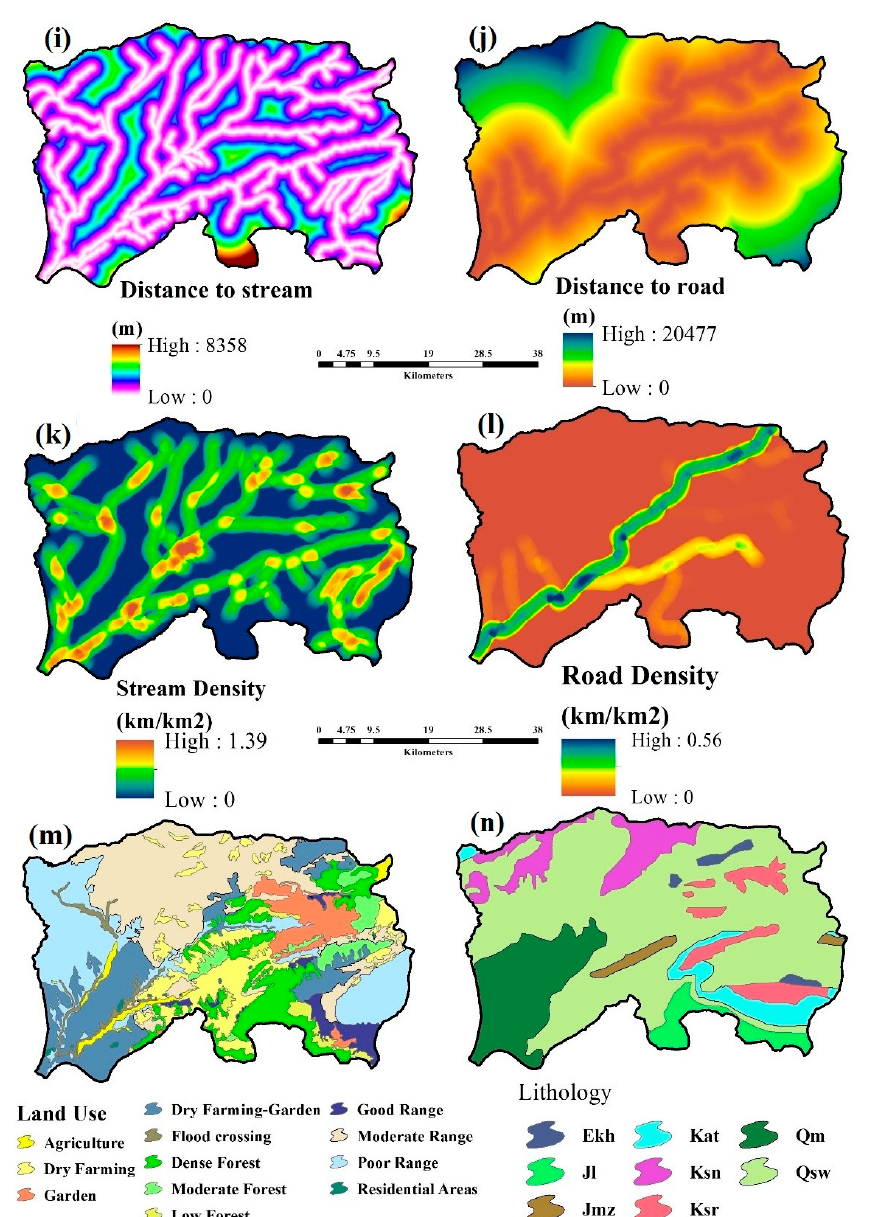
Figure 4. Gully erosion conditioning factors: ( a ) elevation, ( b ) valley depth, ( c ) relative slope position (RSP), ( d ) height above nearest drainage (HAND), ( e ) slope length, ( f ) slope, ( g ) rainfall, ( h ) slope aspect, ( i ) distance to stream (DtS), ( j ) distance to road (DtR), ( k ) stream density, ( l ) road density, ( m ) LULC, and ( n ) lithology.